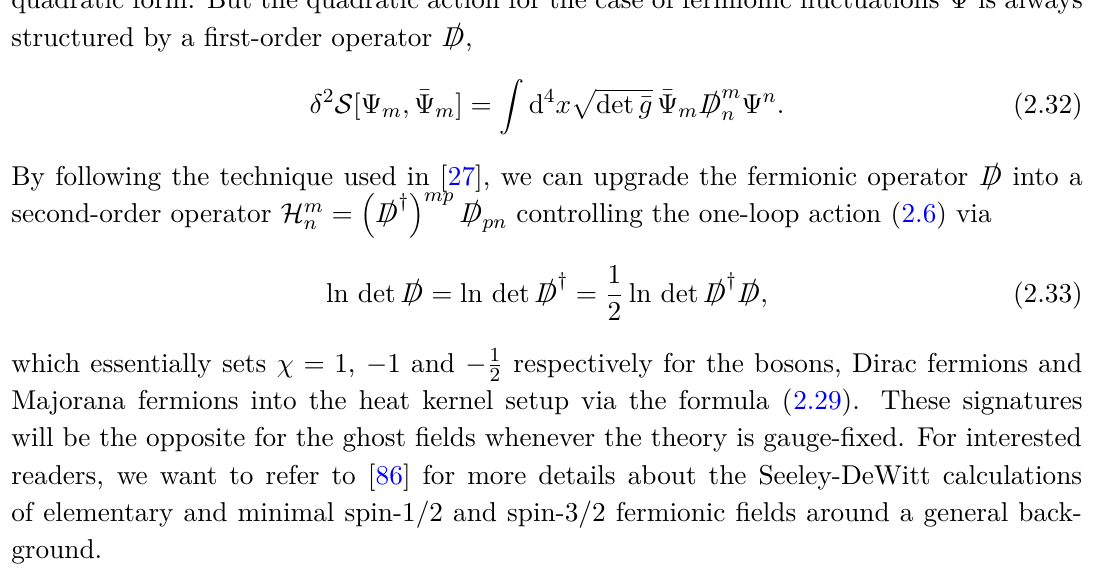
The above-mentioned heat kernel approach strictly demands the kinetic operator H in a quadratic form. But the quadratic action for the case of fermionic fluctuations Ψ is